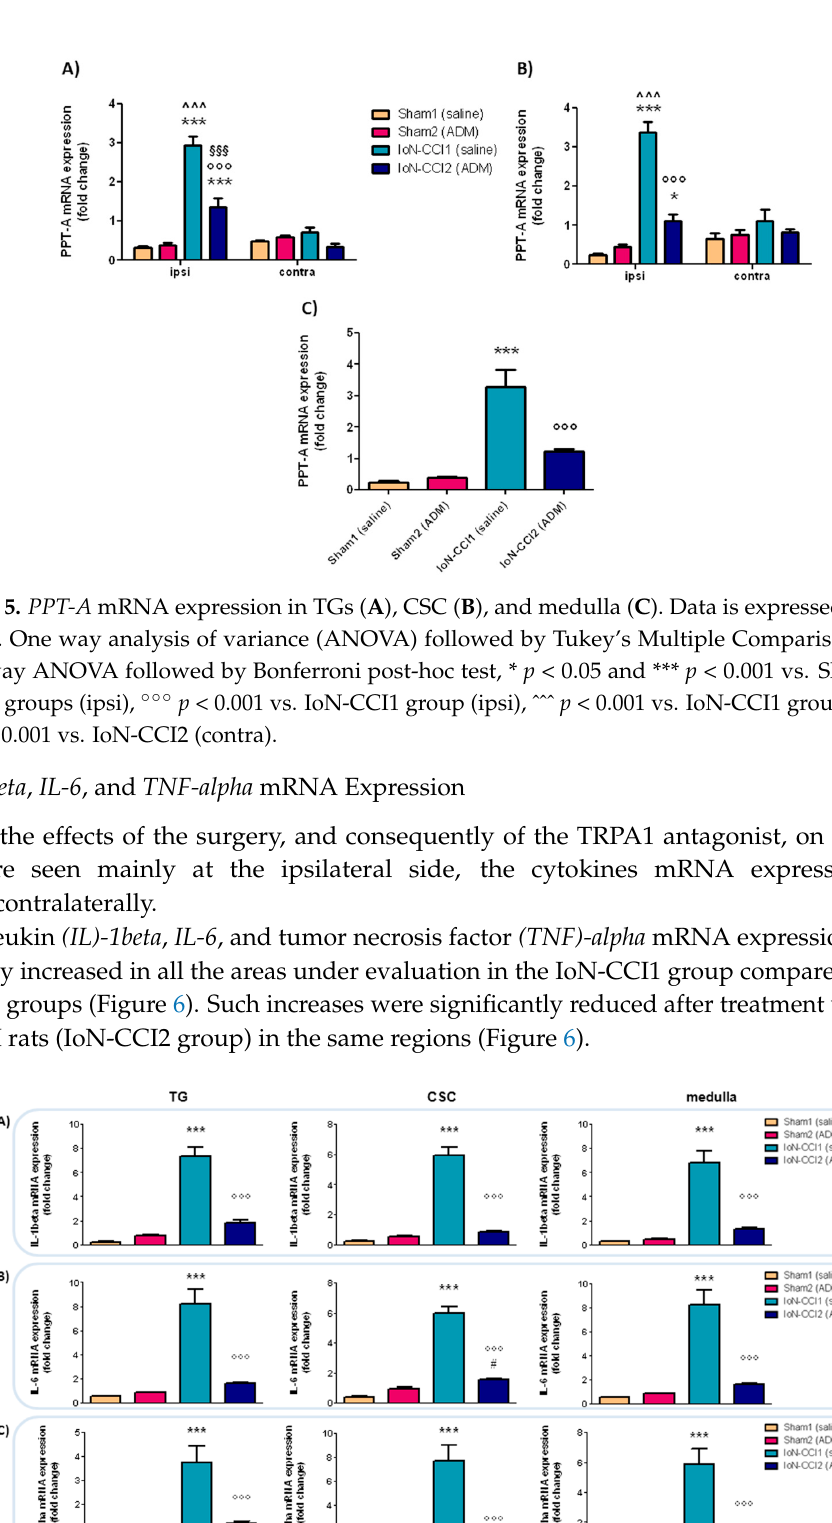
Figure 7. ( A ) Optical density (OD) values of calcitonin gene-related peptide (CGRP) with representative photomicrographs of CGRP immunoreactive fibers in the spinal nucleus of trigeminal nerve pars caudalis (Sp5C) ipsilateral (ipsi) and contralateral (contra) of Sham1 and IoN-CCI1 groups. ( B ) OD values of substance P (SP) with representative photomicrographs of SP immunoreactive fibers in the Sp5C ipsilateral (ipsi) and contralateral (contra) of Sham1 and IoN-CCI1 groups. Data is